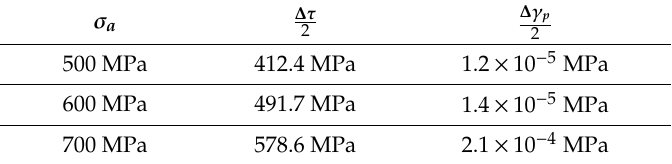
) and plastic slip per cycle ( (cid:2870) 2